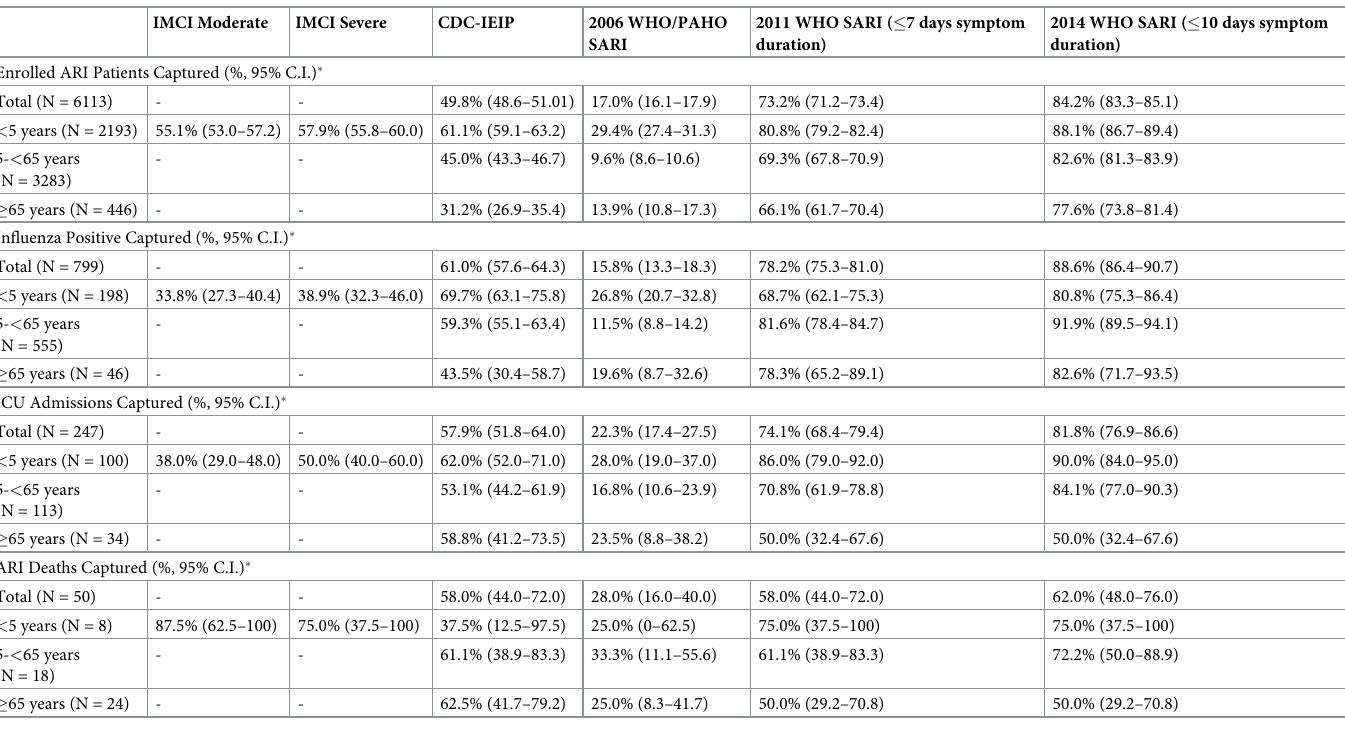
Table 2. Acute Respiratory Illness (ARI) patients captured by case